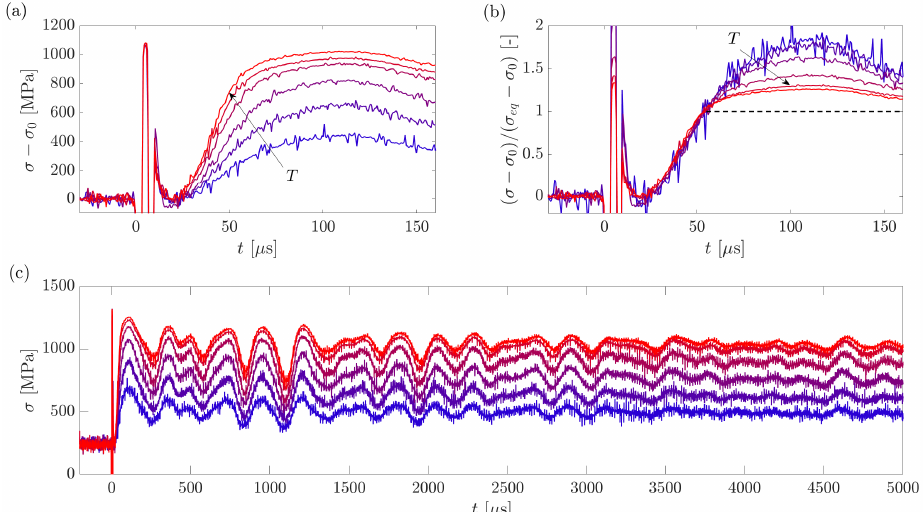
Figure 7. Effect of temperature on typical experiments in the clamp-clamp configuration. The wire [ 100,120, 142,168,195, 209 ] . ( a ) Zoom- temperatures immediately after the pulse are in the range T ∈ in on the beginning of stress versus time curves measured by one of the force sensors, using the same wire and same initial stress, under different input energies. ( b ) Normalized stress profiles (the left hand side of Equation (17)) for the curves presented in ( a ). ( c ) The stress versus time curves in ( a ) presented over a larger period in the millisecond scale, showing the change in equilibrium